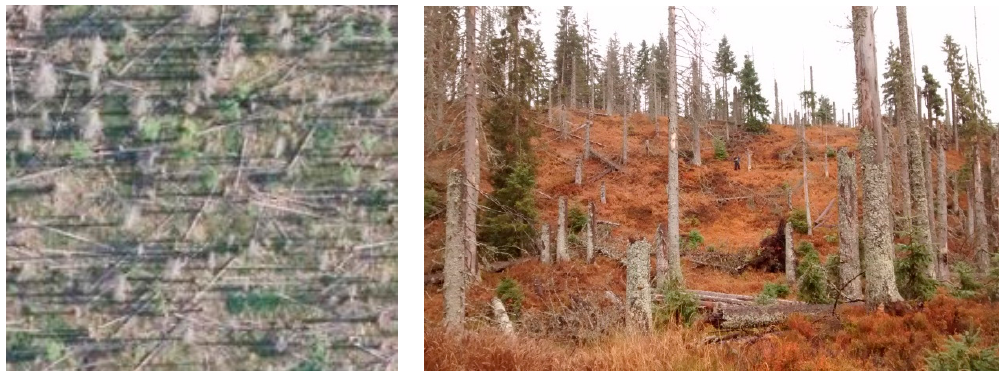
Figure A4. Aerial photo and photo of class A4.